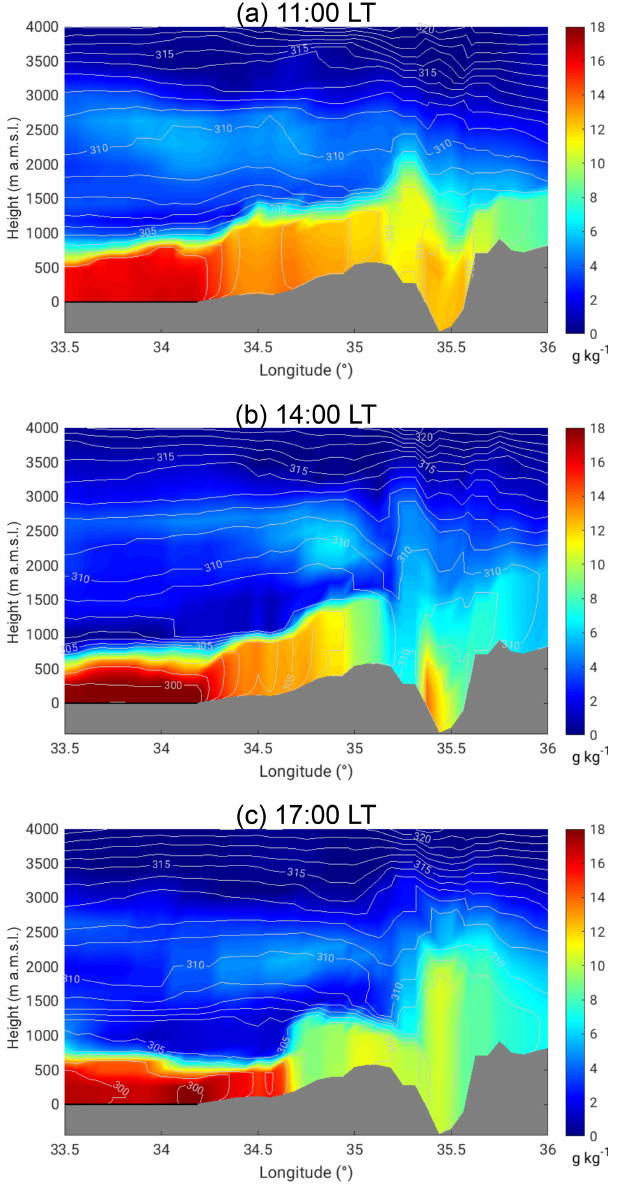
Figure 11. West–east cross section of u-wind component (coloured) and potential temperature (isolines) at the latitude of Masada (31.3125 ◦ N) from COSMO-EU analysis data for 16 August 2014.